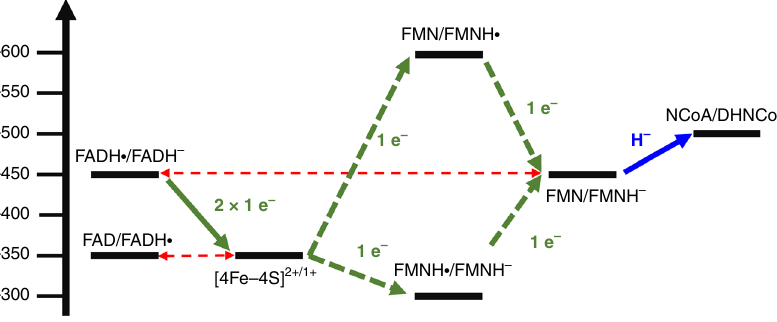
Fig. 8 Electrochemical landscape for the electron transfer reactions during NCR catalysis. After one-electron reduction of the [4Fe – 4S] cluster and FAD, respectively, two-single electrons are transferred to FMN to form a hydride after protonation that is subsequently transferred to NCoA. While FAD switches only between the SQ/HQ states, an FMN SQ intermediate was never observed. This fi nding is rationalized by largely differing crossed-over redox potentials of the two redox transitions of FMN (the values shown are minimal estimates based on the inability to observe the FMN SQ in the steady state). As a result, the second reduction drives the unfavorable fi rst reduction resulting in the observed two-electron reduction of FMN. For the NCoA/DHNCoA couple the standard redox potential is given, which under cellular conditions will be slightly more positive si -side of the substrate with a distance between its oxygen and C5 of 2.7 Å strongly suggesting a function as proton donor during transfers the proton to C5 of the 6-hydro-NCoA anion with a small barrier of only about 2 kcal/mol.